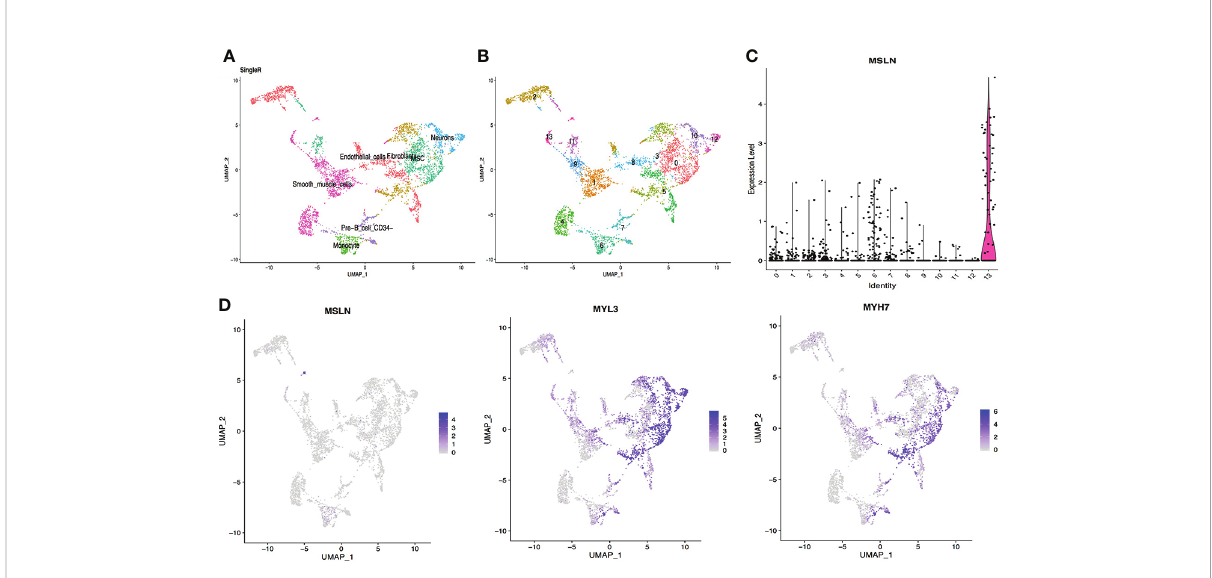
FIGURE 1 Analysis of cardiac scRNA-seq data showing high expression of MSLN in myocardial cells. (A) Cell types in the heart according to SingleR. (B) Cells in the heart were categorized into 14 different clusters, numbered 0 to 13. (C) Violin plot of MSLN expression distribution in these 14 different cell clusters. (D) Scatter plots showing that the cluster of cells with high expression of MSLN also expressed the typical myocardial cells markers MYL3 and